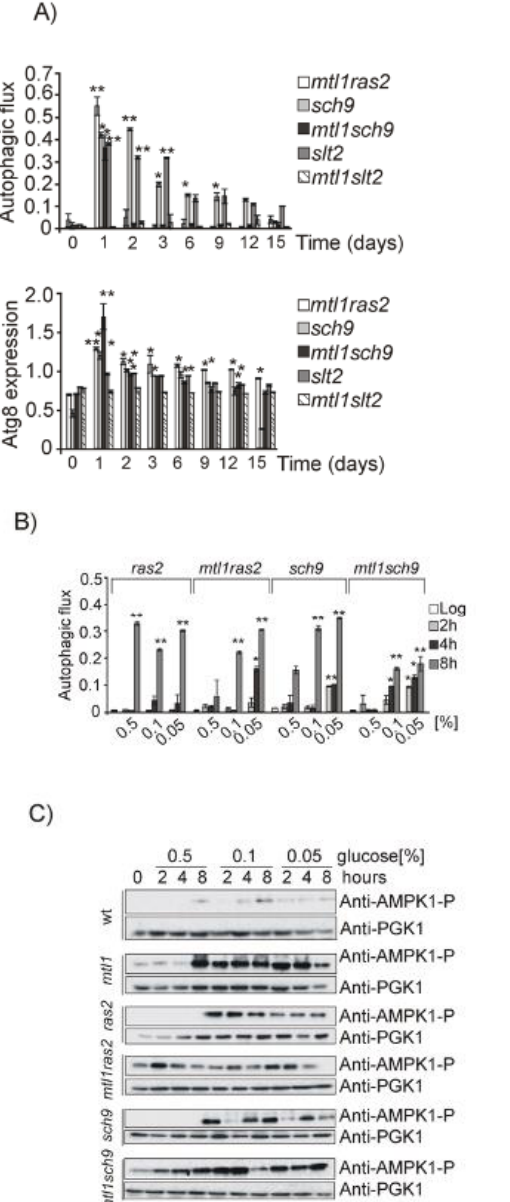
Figure 6. Both Ras2 and Sch9 suppress mtl1 deficiency in autophagy signaling upon glucose concentration decreasing. ( A ) mtl1ras2, sch9, mtl1sch9, slt2, mtl1slt2, wt+pBcy1, mtl1 +pBcy1, wt+p BCK1-20 , mtl1 +p BCK1-20 , wt+pPkc1* and mtl1 +pPkc1* strains expressing GFP – Atg8 were grown at 30°C in SD media for 15 days. Samples were taken to determine autophagic flux and total Atg8 expression as described in Figure 1B. ( B ) Strains ras2, mtl1ras2, sch9, and mtl1sch9 expressing GFP – Atg8 were exponentially grown in SD media to be subsequently transferred to minimum medium containing the indicated concentration of glucose. Samples were taken to determine autophagy as in Figure 4A. ( C ) wt samples (from Figure 4A) and mtl1 samples (from Figure 4C) along with mtl1, ras2, mtl1ras2, sch9 and mtl1sch9 samples (from Figure 6B) were used for Western blot analysis and AMPK1 detection by using anti-AMPK1-P antibody. Error bars in the histograms represent the standard deviation (SD) calculated from three independent experiments. Significance of the data was determinate by p- values from a Student’s unpaired t -test denoted as follows: * = 0.05 p 0.01; ** = 0.01 p 0.001.